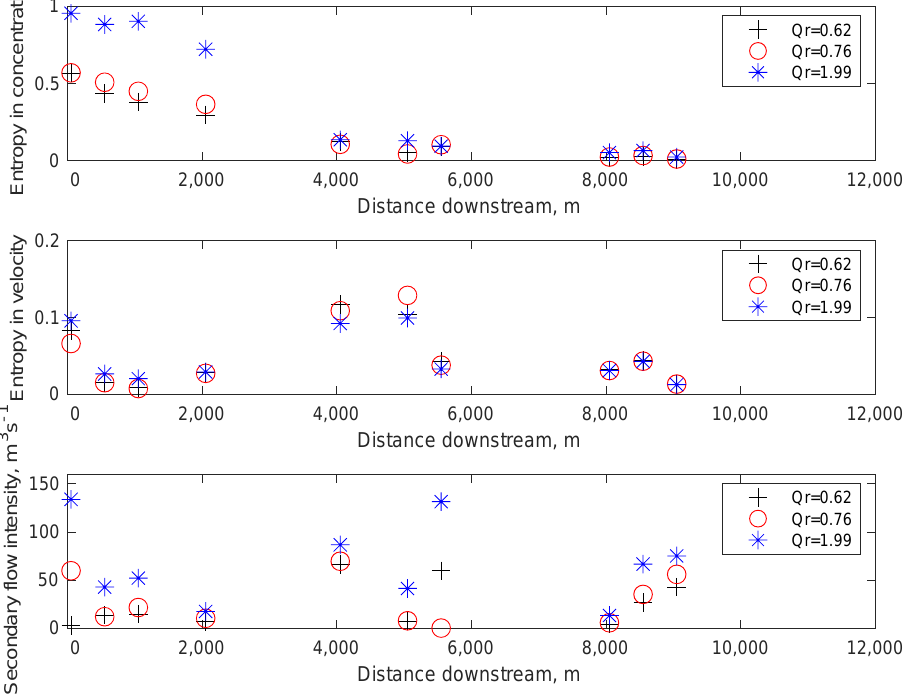
Figure 10. Longitudinal distribution of entropy of concentration, entropy of velocity, and secondary flow intensity for di ff erent values of the discharge ratio for the N simulations.